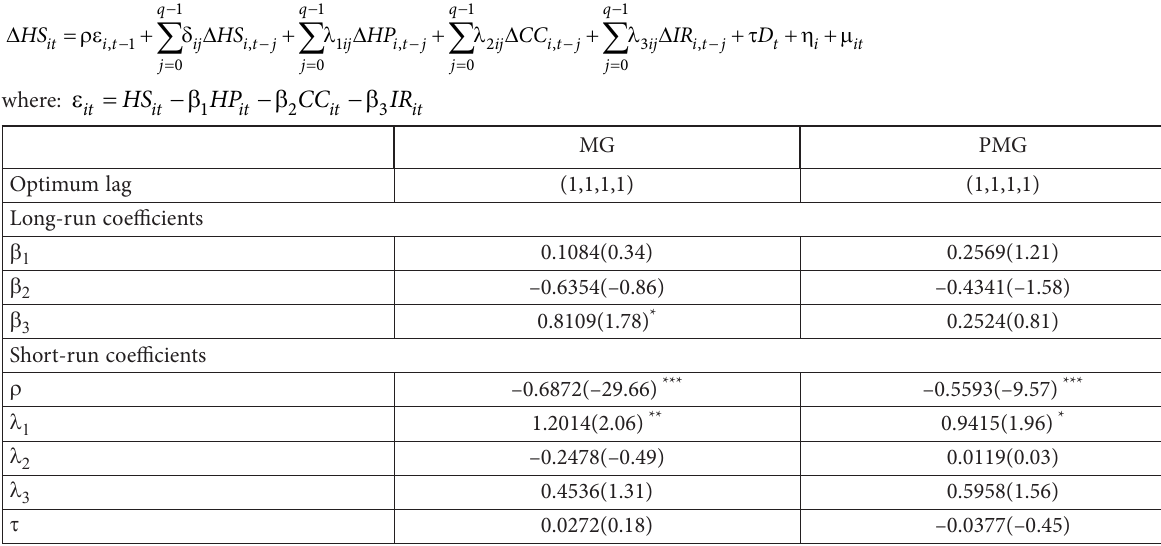
Table 5. Results of linear relation between housing starts and house price